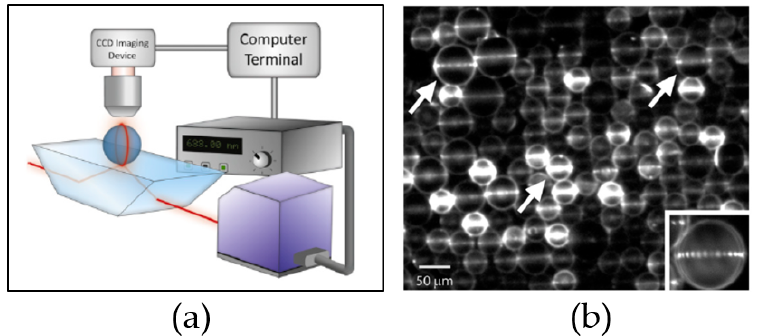
Figure 14. The configuration of ovarian cancer biomarker detection. ( a ) The system is based on a previous experiment but uses prism coupling for expanding the excitation area; ( b ) Fluorescence image revealing the illumination of some spheres specific for different markers. Reprinted with permission from [27].